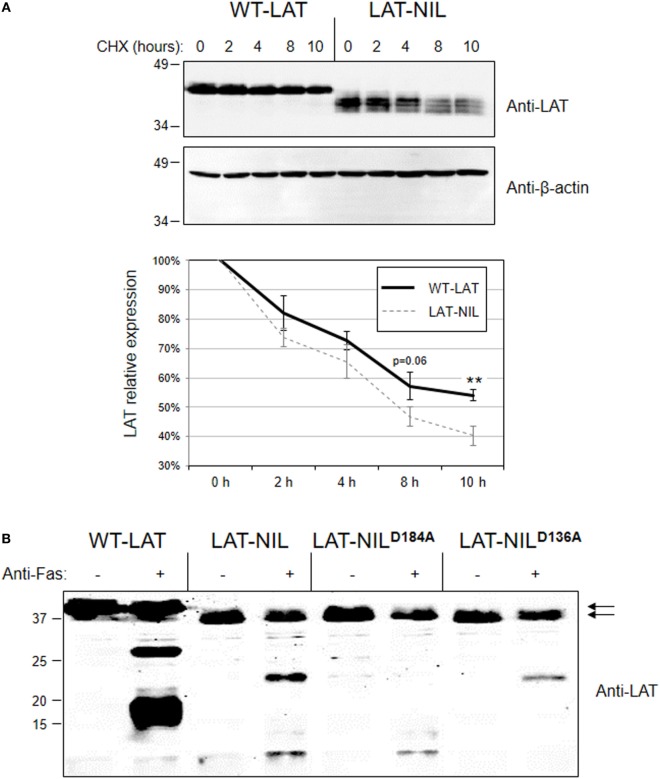
Degradation of WT-linker for activation of T cell (LAT) and LAT-NIL mutant proteins. (A) Cell extracts from J.CaM2 cells expressing WT-LAT or the LAT-NIL mutant were treated with cycloheximide (CHX) for indicated time in hours, and LAT (upper panel) or beta-actin (middle panel) protein levels were detected by Western blot. Densitometric analysis was performed over eight experiments and the relative expression of LAT was represented (lower panel). Bars represent the standard error. Asterisks represent statistical significance. (B) J.CaM2 cells expressing WT-LAT or the indicated mutants were treated for 4 h at 37°C with 100 ng/ml of anti-Fas antibody, and LAT cleavage was assessed in total cell lysates by Western blot with anti-LAT antibody. Molecular masses in kDa are indicated adjacent to the Western blot. Arrows indicate the bands corresponding to the whole WT-LAT molecule (upper arrow) and LAT-NIL (lower arrow).